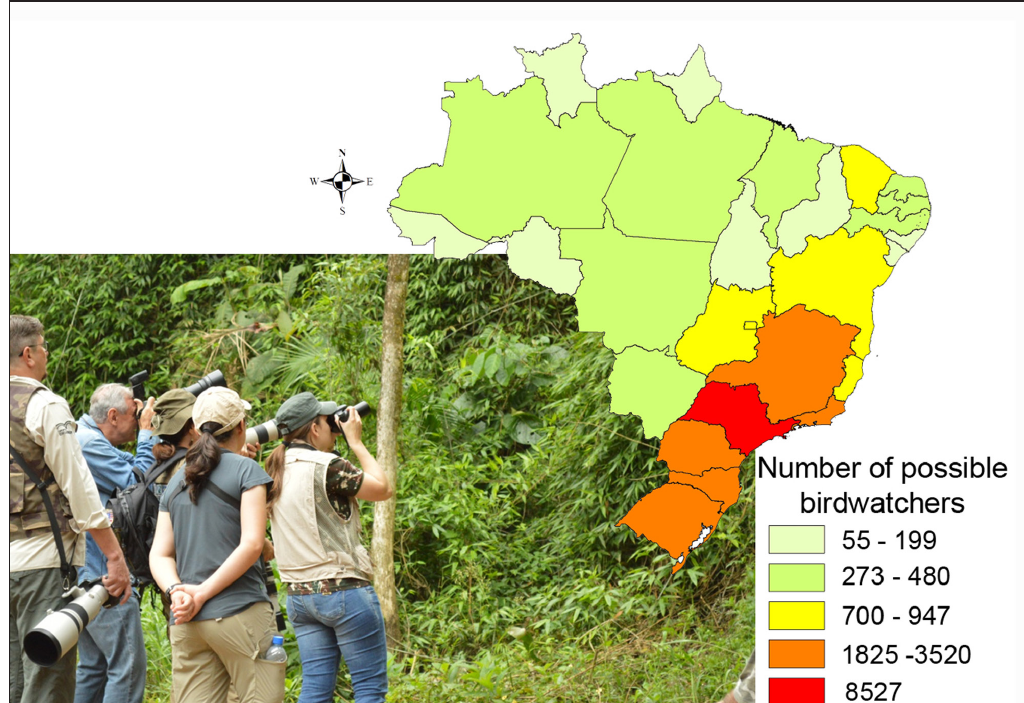
Figure 1: Number of possible birdwatchers in Brazil represented by WikiAves users (WikiAves 2018). WikiAves is the most popular website for bird record sharing used by Brazilian birdwatchers. The figure highlights distribution of WikiAves users by Brazilian states (data from 11 August 2018). Photo: Eduardo R.